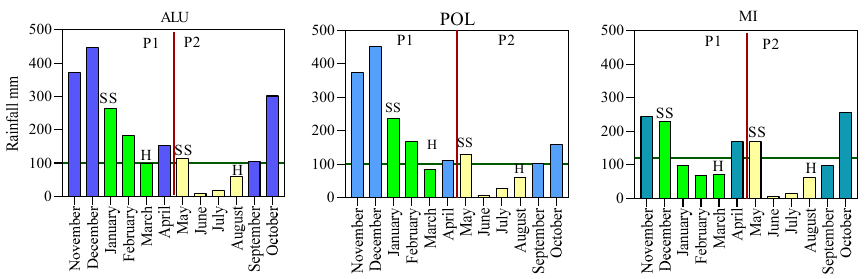
Figure 8. Long term (2009–2019) mean cumulative monthly rainfall (mm) of three production location Aluttarama (ALU), Polonnaruwa (POL) and Mahailluppalama (MI). Source: Natural resource management division, Department of Agriculture Sri Lanka.